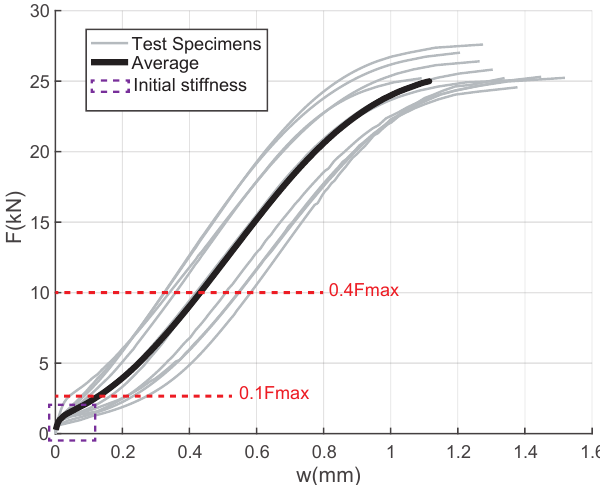
Figure 6. Experimental curves for TT connection